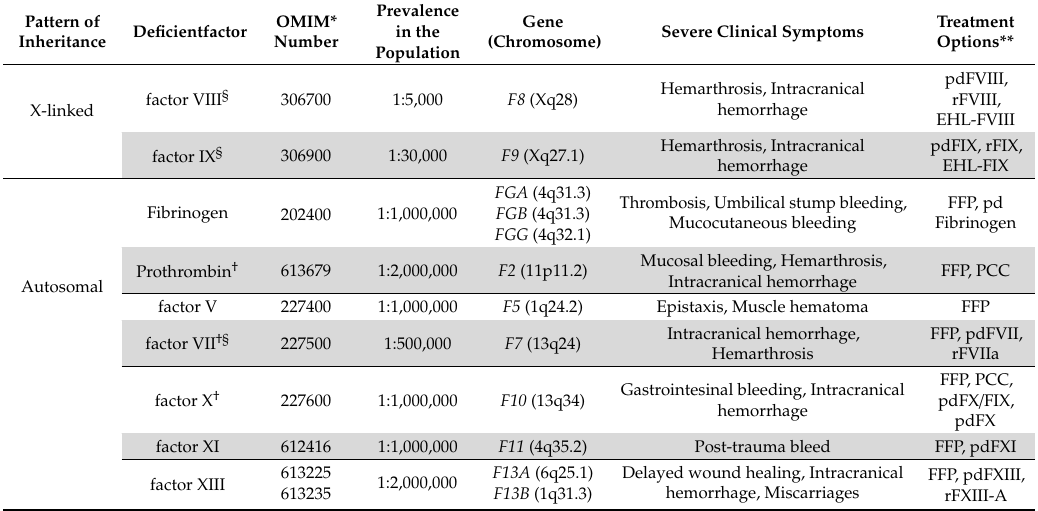
Table 1. Coagulation factor deficiencies: genetics, severe symptoms and treatment